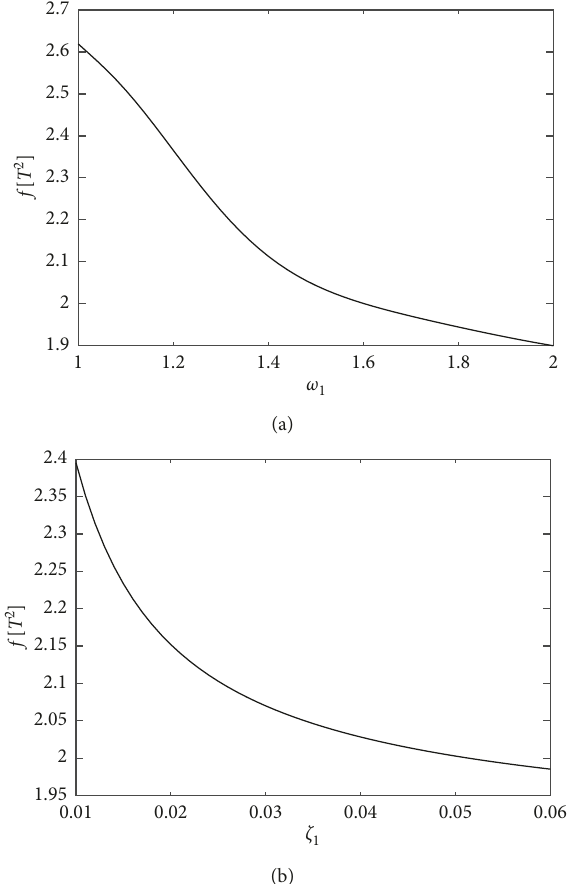
Figure 5: f [ T 2 ] [s 2 ] (equation (33)) as a function of natural fre- quency ω 1 (Hz) and modal damping ratio ζ 1